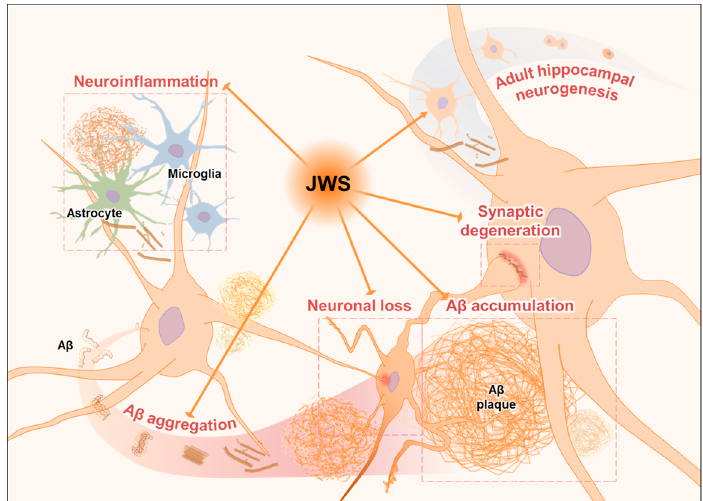
Figure 6. A schematic diagram of the protective effect of jowiseungchungtang (JWS) on A β -induced pathology. It is possible that JWS up-regulates adult hippocampal neurogenesis and inhibits A β accumulation and thereby decreases neuroinflammation and neurodegeneration in 5XFAD mice. T bar indicates suppression, and arrow indicates enhancement.